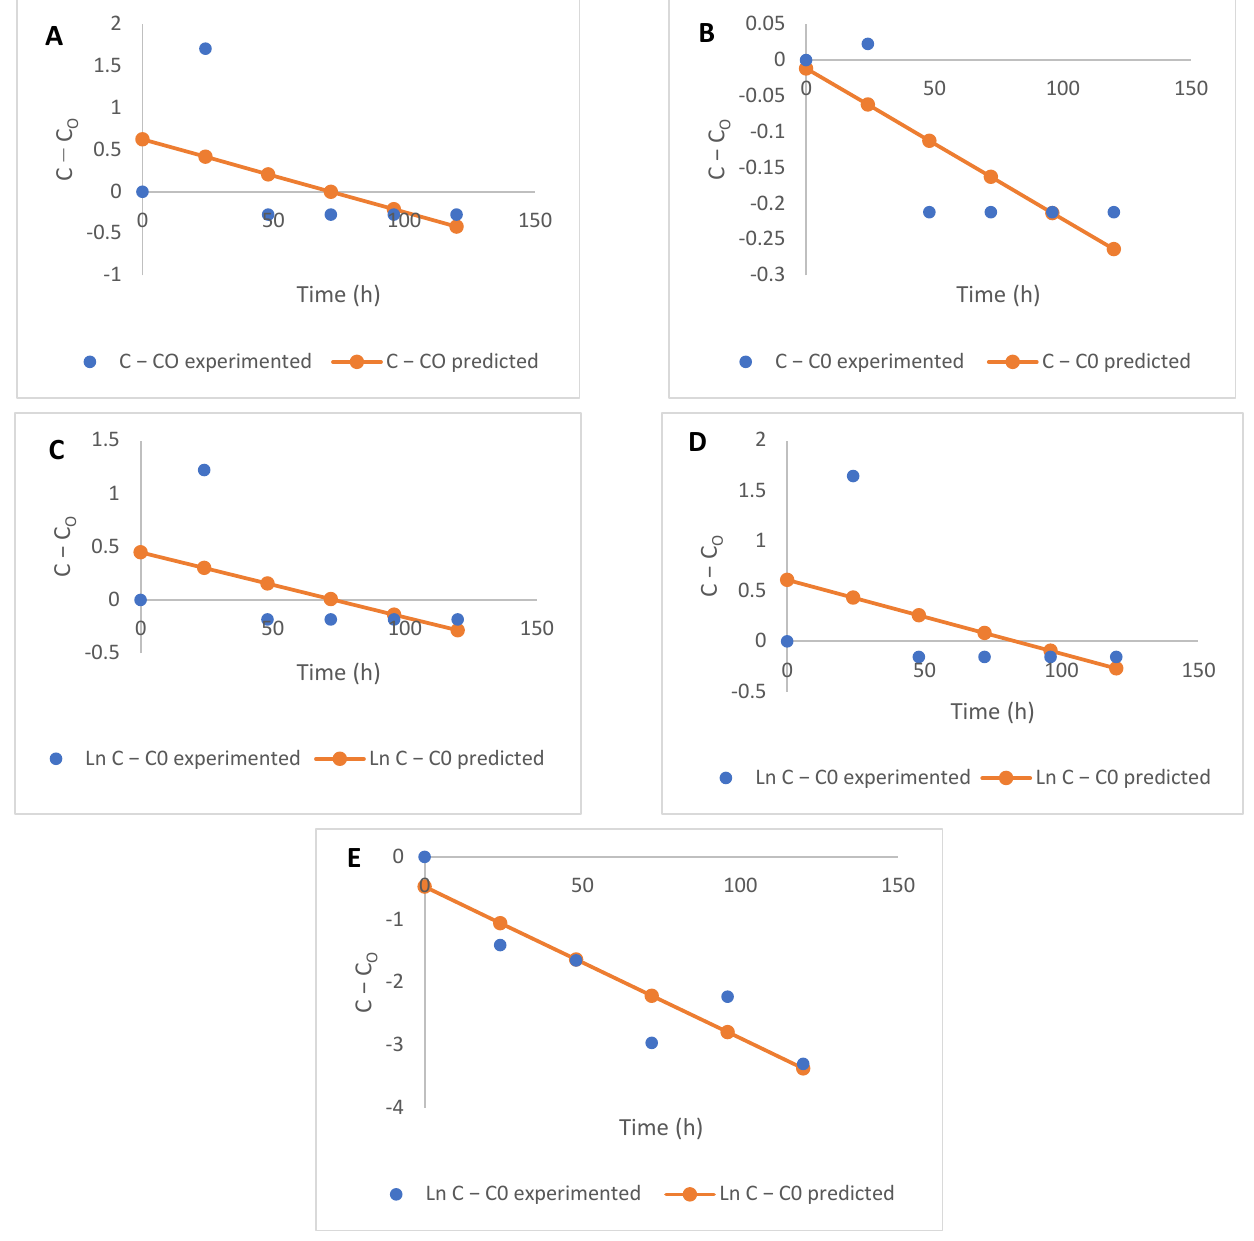
Figure 3. Kinetics (zero-order) of bound flavonoid degradation during the fermentation of maize flour ( A ) apigenin, ( B ) kaempferol, ( C ) luteolin, ( D ) quercetin, and ( E ) taxifolin.